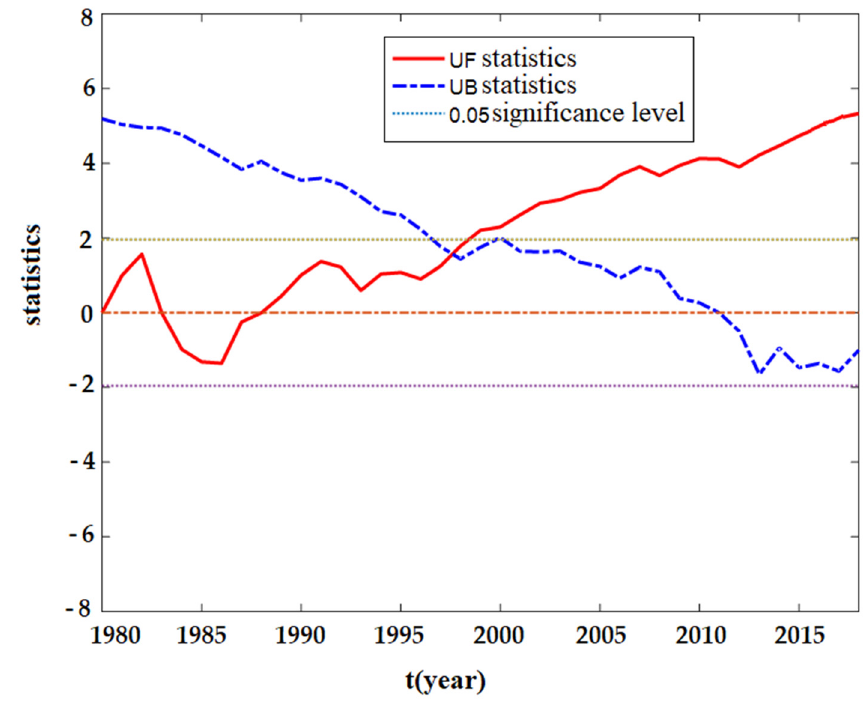
Figure 5. Trend of M–K statistics of air temperature.